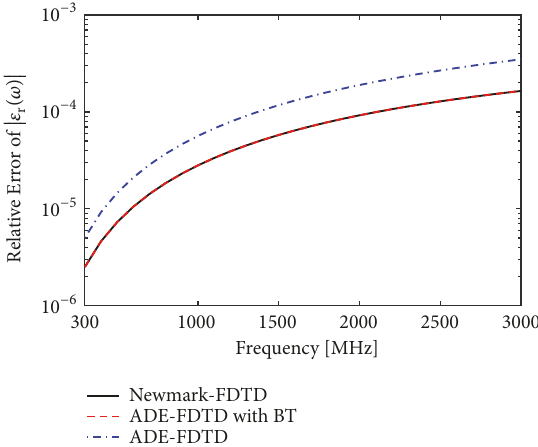
Figure 1: Relative error of the numerical